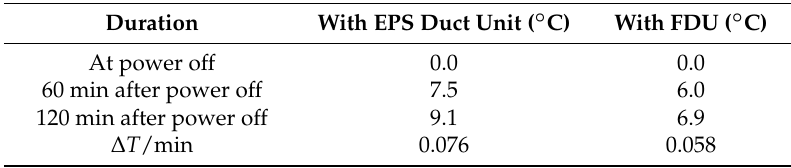
Table 5. Comparisons of temperatures and variation rates measured in the refrigerating compartment after power